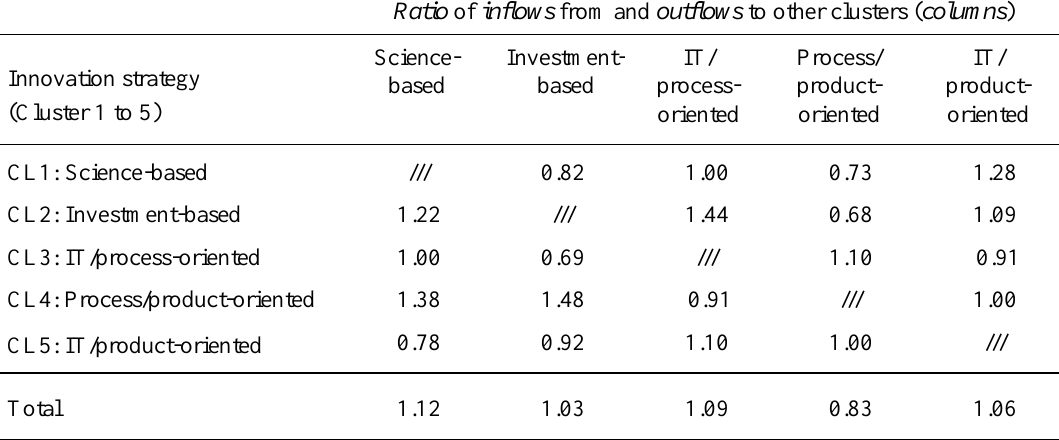
a Ratio of inflows from and outflows to other clusters ( columns ) Investment- IT/ Science- Process/ IT/ based process- based product- product- oriented oriented oriented 0.82 1.00 0.73 1.28 1.09 0.91 /// 0.78 0.92 1.10 ///